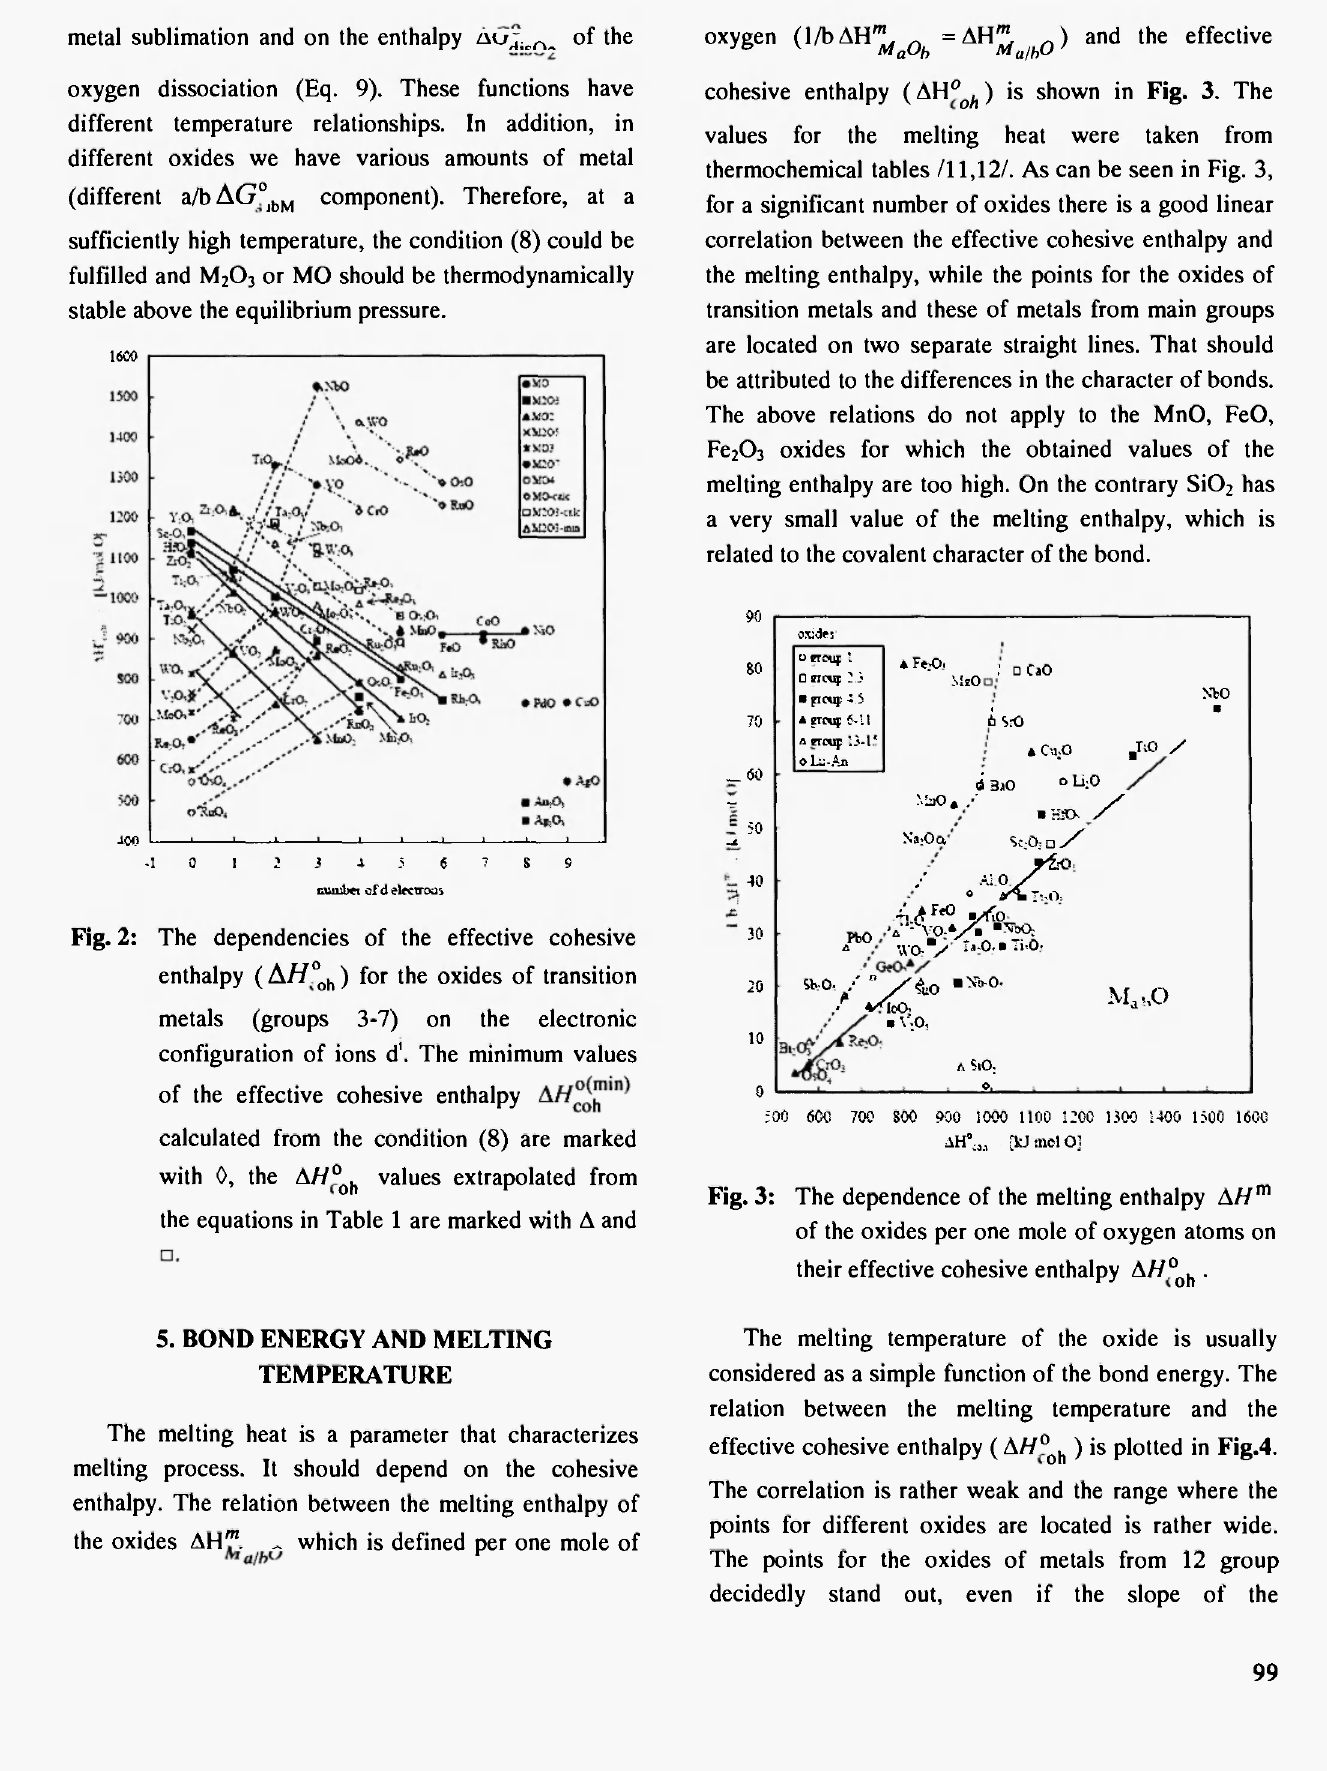
Fig. 3: The dependence of the melting enthalpy AH m of the oxides per one mole of oxygen atoms on their effective cohesive enthalpy Δ//° ο|)